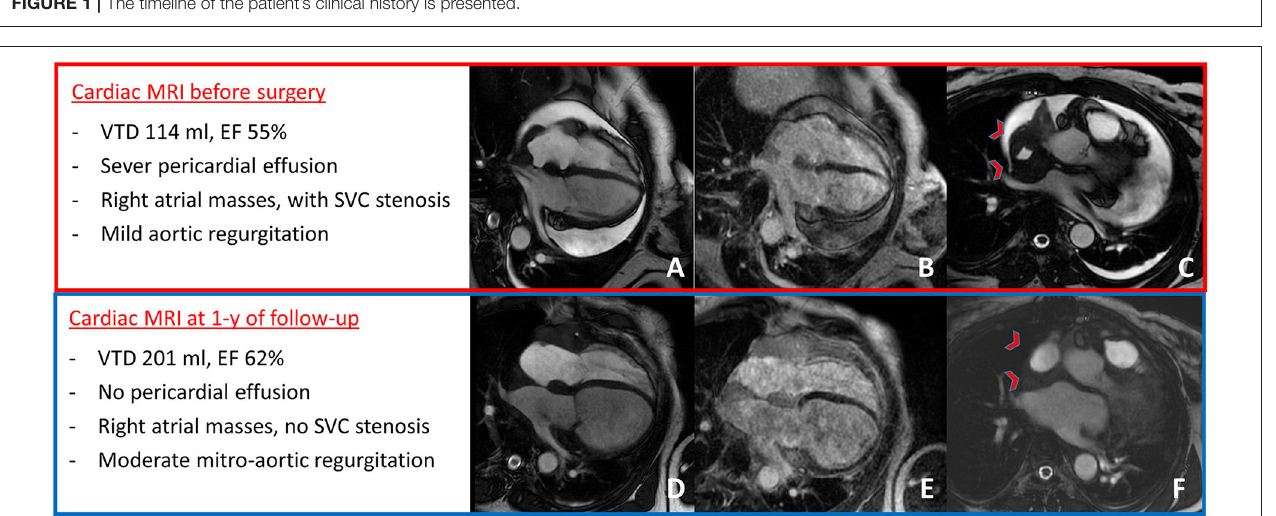
FIGURE 1 | The timeline of the patient’s clinical history is presented.